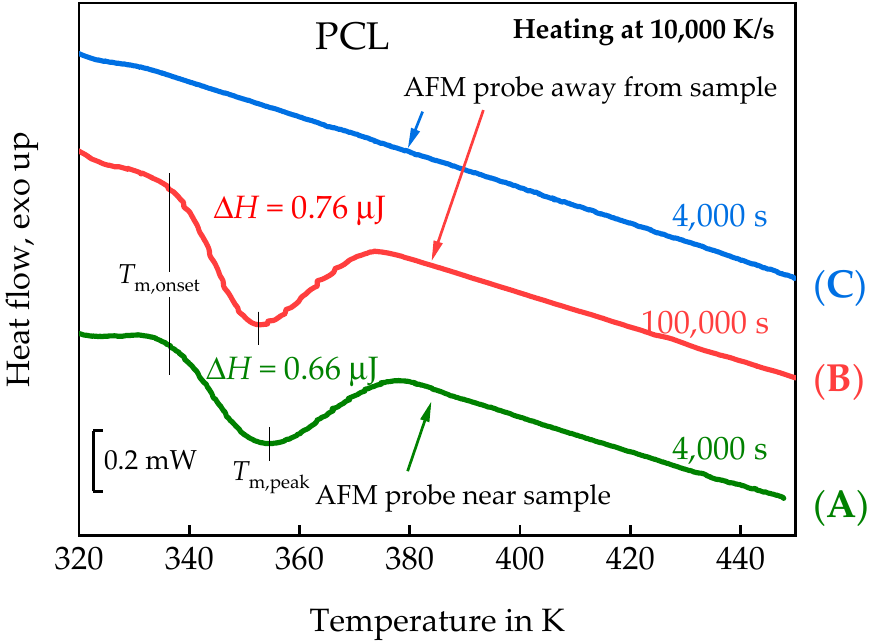
Figure 6. FSC heating scans of PCL after annealing at 325 K at different conditions regarding the placement of the AFM tip. Curve ( A )—After collecting the images of Figure 5 (5000 s at 325 K, AFM in non-contact mode, about 5–10 nm distant to the sample). Curve ( C )—same annealing time at 325 K as in case of curve ( A ) but with the AFM tip about 100 µm away from the sample. Curve ( B )—AFM probe far away from the sample and annealing time at 325 K increased to 100,000 s.